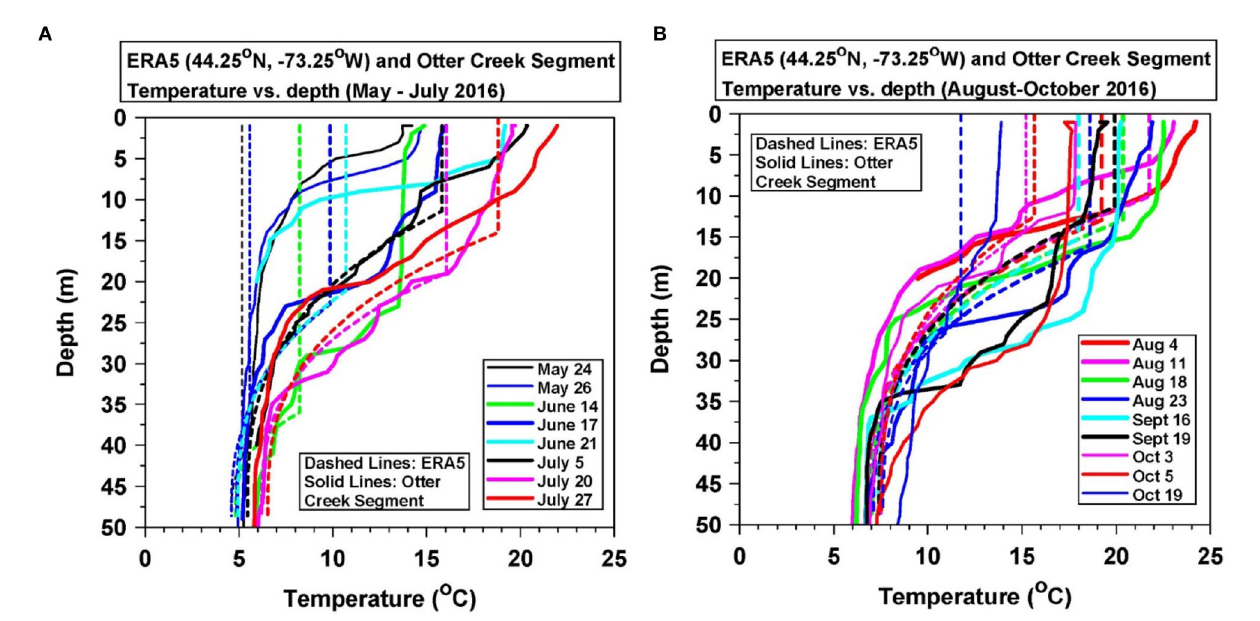
FIGURE 5 | (A) Comparison of temperature depth profiles between ERA5 (dashed) and Otter Creek Segment (solid) for the same dates: May to July and (B) August to